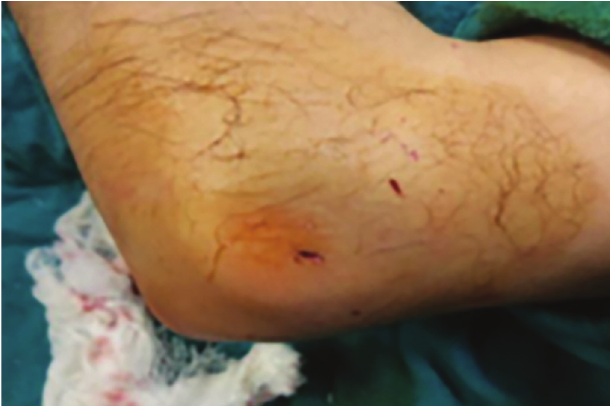
Figure 2 - Eliciting tenderness at lateral epicondyle